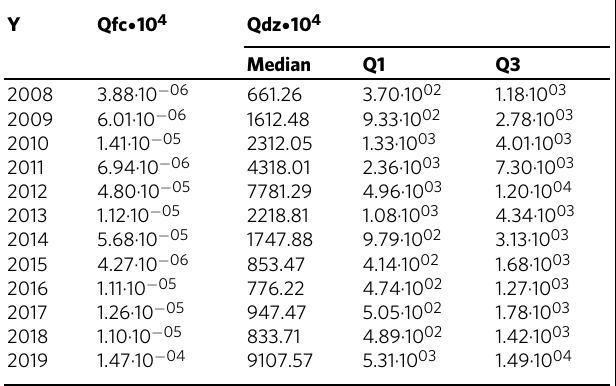
Table 2 Rate of 4 He in deformed